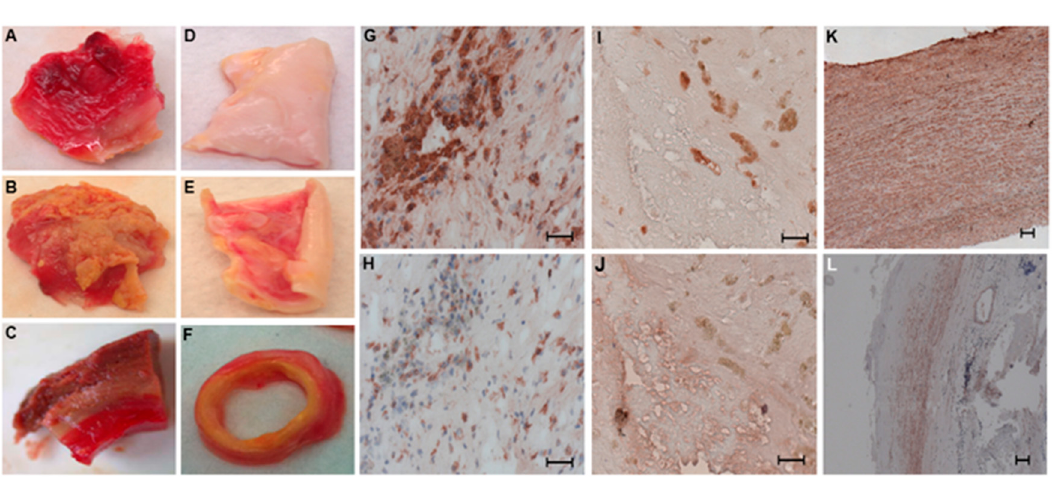
Figure 1. Macroscopic analysis of aneurysmal ( A – C ) and control aortas ( D – F ) and distribution of M1 and M2 macrophages in aneurysmal aortas ( G – J ) and of smooth muscle cells (SMCs) in control ( K ) and aneurysmal ( L ) aortas. Representative internal ( A , D ) and external ( B , E ) view of aneurysmal and control aortas. Sections of control and aneurysmal aortas were prepared on transversal slides ( C , F ) for histology and immunohistochemistry. The entire population of macrophages was stained with an anti-CD68 antibody ( G , I ) and the subtype M1 (CD68 + MR – ) ( H ) and M2 (CD68 + MR + ) ( J ) was discriminated and visualized by an anti-macrophage mannose receptor (MR) antibody (Scale bar: 50 µm). SMCs, stained with α -smooth muscle actin ( α -SMA) antibody, were present throughout the control aortas ( K ) and only detected in the media of aneurysmal aortas ( L ) (Scale bar: 100 µm). Immunostaining analysis was performed in every abdominal aortic aneurysm (AAA) sample ( n = 20) and control aorta sample for SMC ( n = 14) collected.